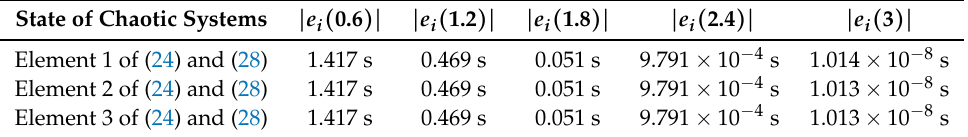
Table 3. Absolute values of errors between two nonidentical chaotic systems (24) and (28) equipped with controller (6) via the proposed SEZN approach at different time instants during the rejection of chaotic disturbances.